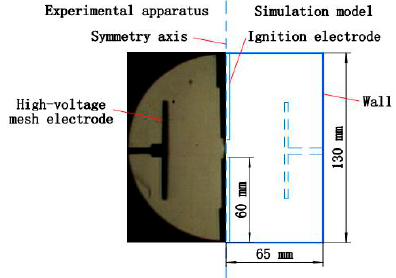
Figure 4. 2D computational domain compared with the experimental apparatus.